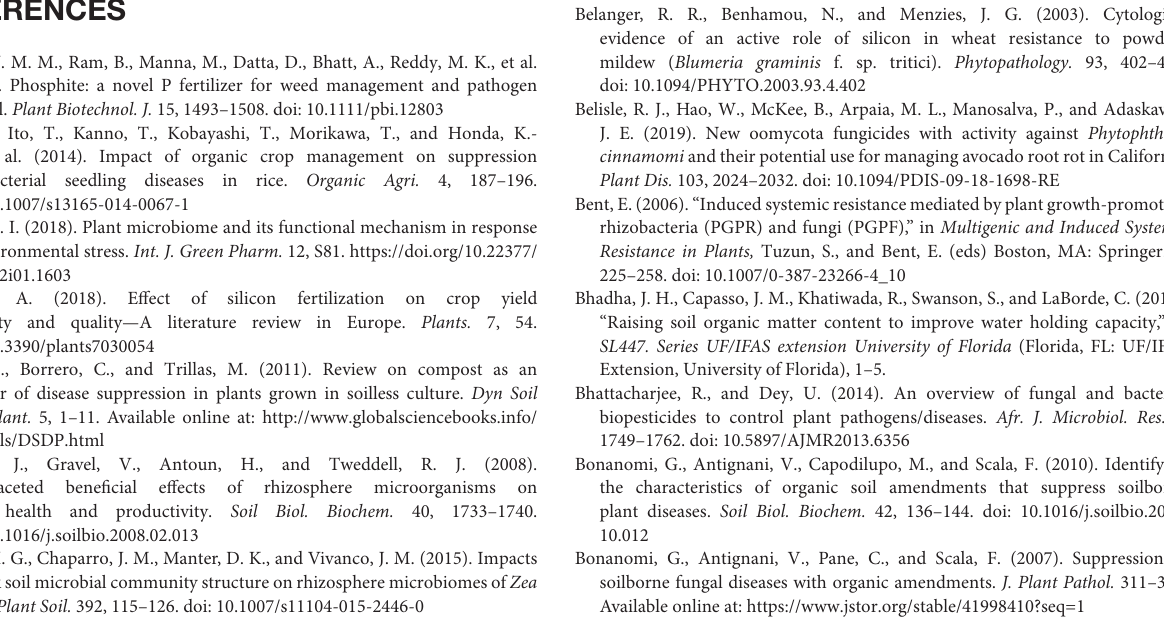
and taxa in tan color are more abundant in treatments in columns. For figure a) and b) the color of each taxon represents the log-2 ratio of median proportion of reads observed in each treatment. Taxa colored in blue are abundant in the treatment mineral mulch whereas taxa colored in tan are more abundant in no mulch. Taxa in gray showed no difference across treatments.